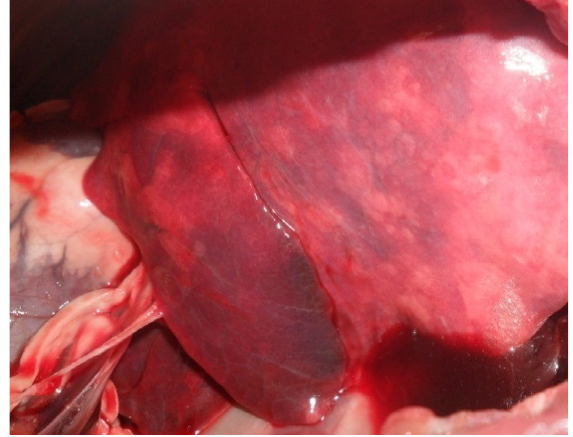
Fig. 5. Left lung showing congestion in a WAD goat suffering from PPR